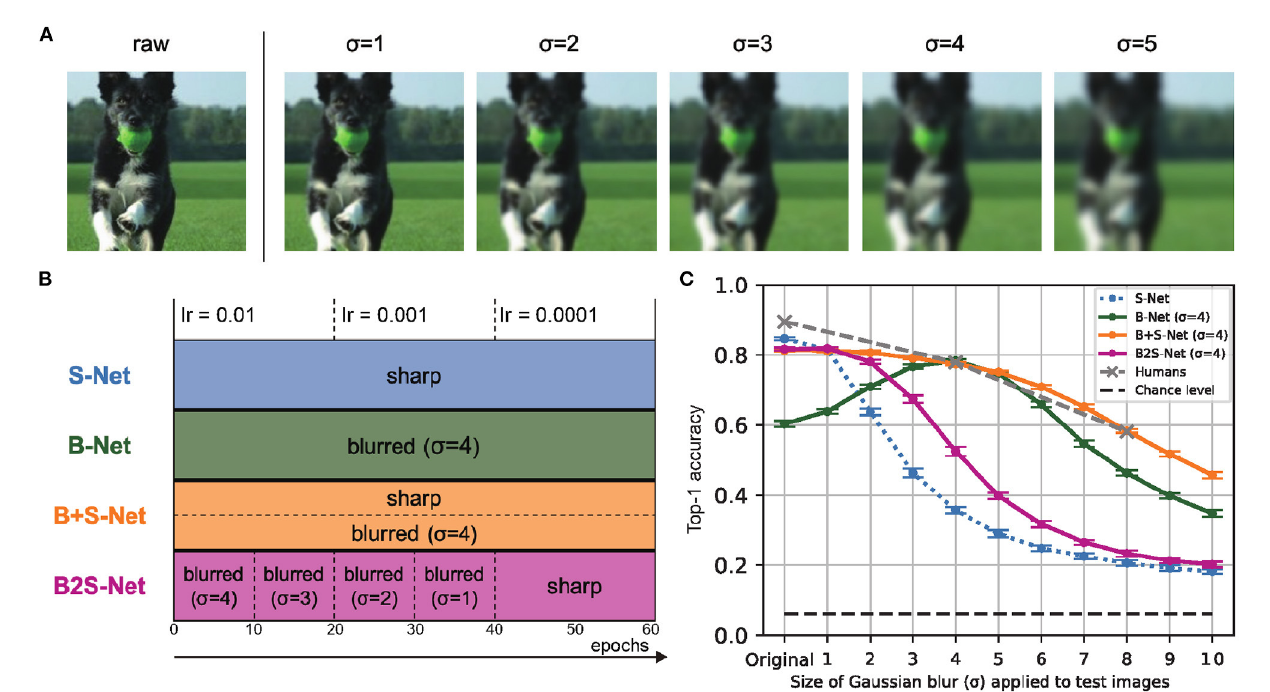
FIGURE1 Blur training brings CNN closer to humans in recognizing low-pass filtered object images. (A) Sample blurred images. (B) Four blur training methods. (C) Classification accuracy on low-pass filtered test images. Top-1 accuracy is the rate at which the model’s first choice matches the expected answer. Error bars represent 95% confidence intervals estimated from the performances of eight models trained with different random seeds.